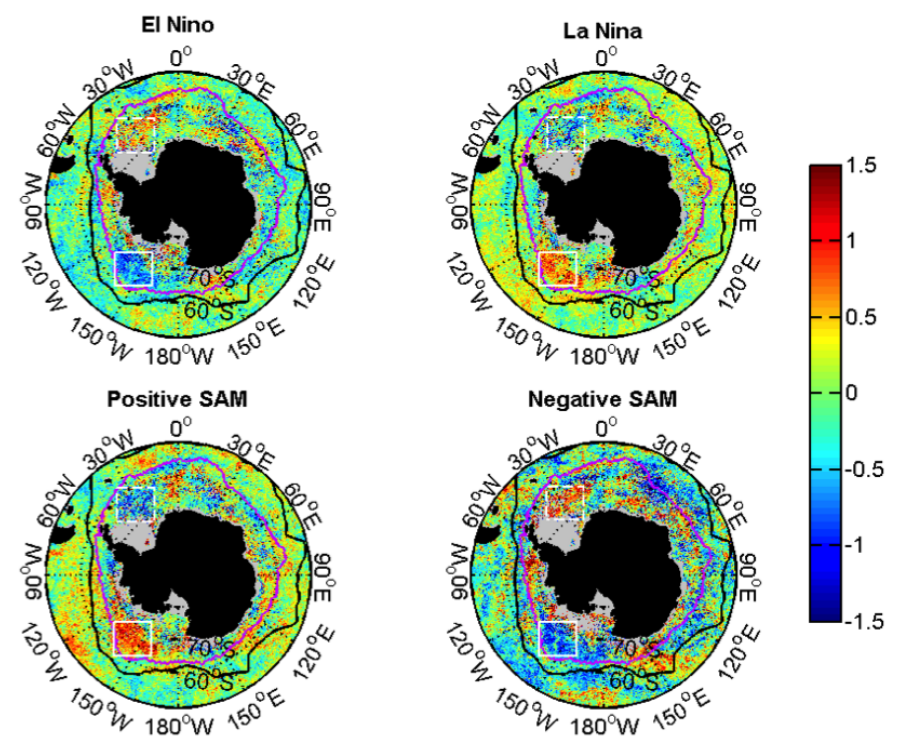
Figure 9. Composites of bloom start date (BSD) standardized anomalies during El Niño ( N = 6), La Niña ( N = 8), positive SAM ( N = 7) and negative SAM ( N = 4) years. Grey areas represent missing data. Black lines show the mean position of the Polar Front [43] over 1997–2012. Purple line displays the median position of the maximum sea ice extent [45] over 1997–2012. The white boxes depict the Weddell Sea region (dashed) and the sector between 120 ◦ W and 180 ◦